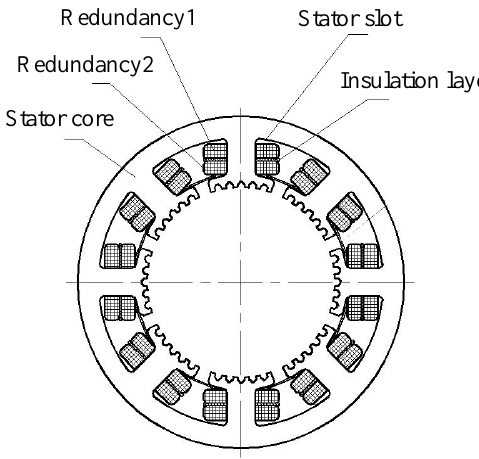
Figure 1. The stator structure of the dual-redundancy HSM. The dual-redundancy HSM has two working modes: dual channel mode and single channel mode. The formula will be slightly changed when the motor works in dual chan- nel mode, i.e., the two windings are energized simultaneously.